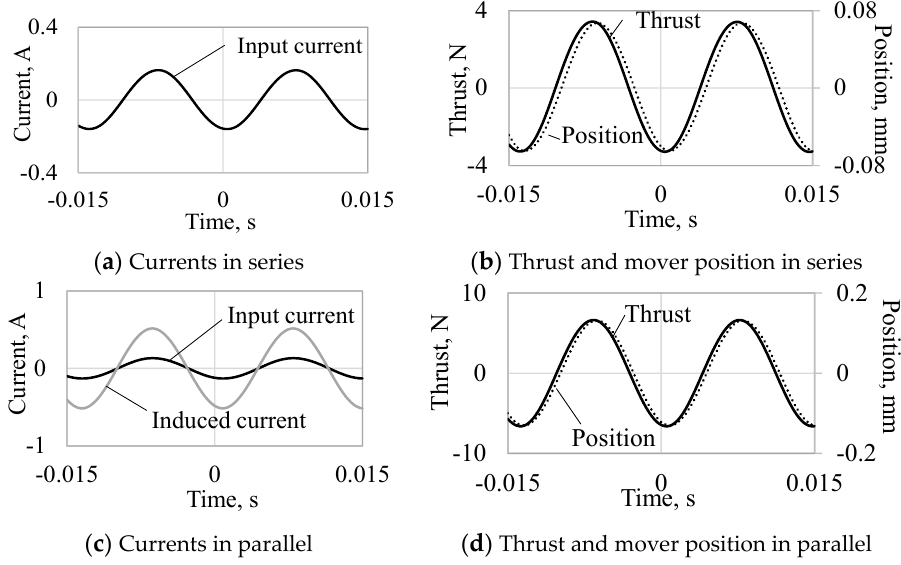
Figure 8. Analyzed results per time variation at 70 Hz.